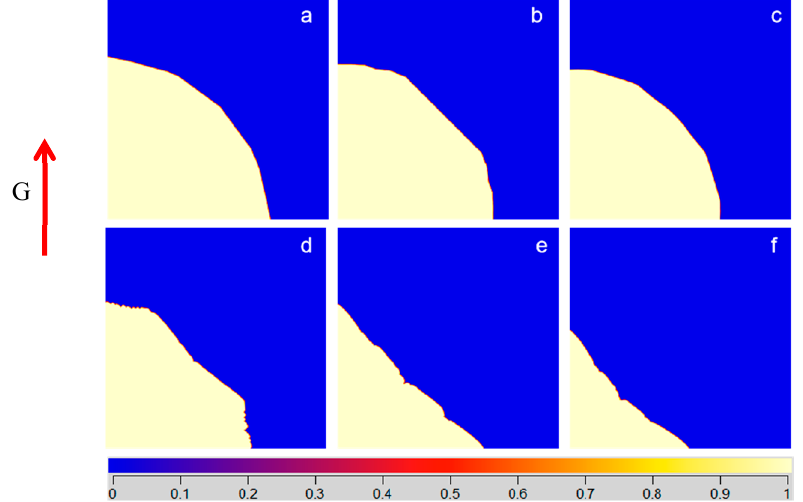
Figure 2. Effect of Fe content on the morphology of a single grain: ( a ) Ti–6Al–4V, ( b ) Ti–6Al–4V–0.1Fe, ( c ) Ti–6Al–4V–0.3Fe, ( d ) Ti–6Al–4V–0.5Fe, ( e ) Ti–6Al–4V–0.7Fe, ( f ) Ti–6Al–4V–0.9Fe.